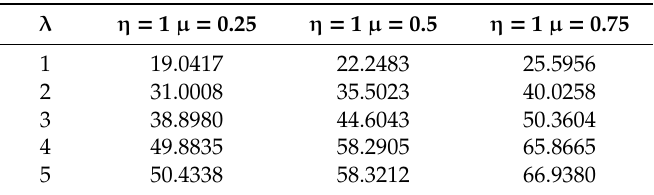
Table 16. First five natural frequencies for the USFG distribution for three di ff erent states of complete